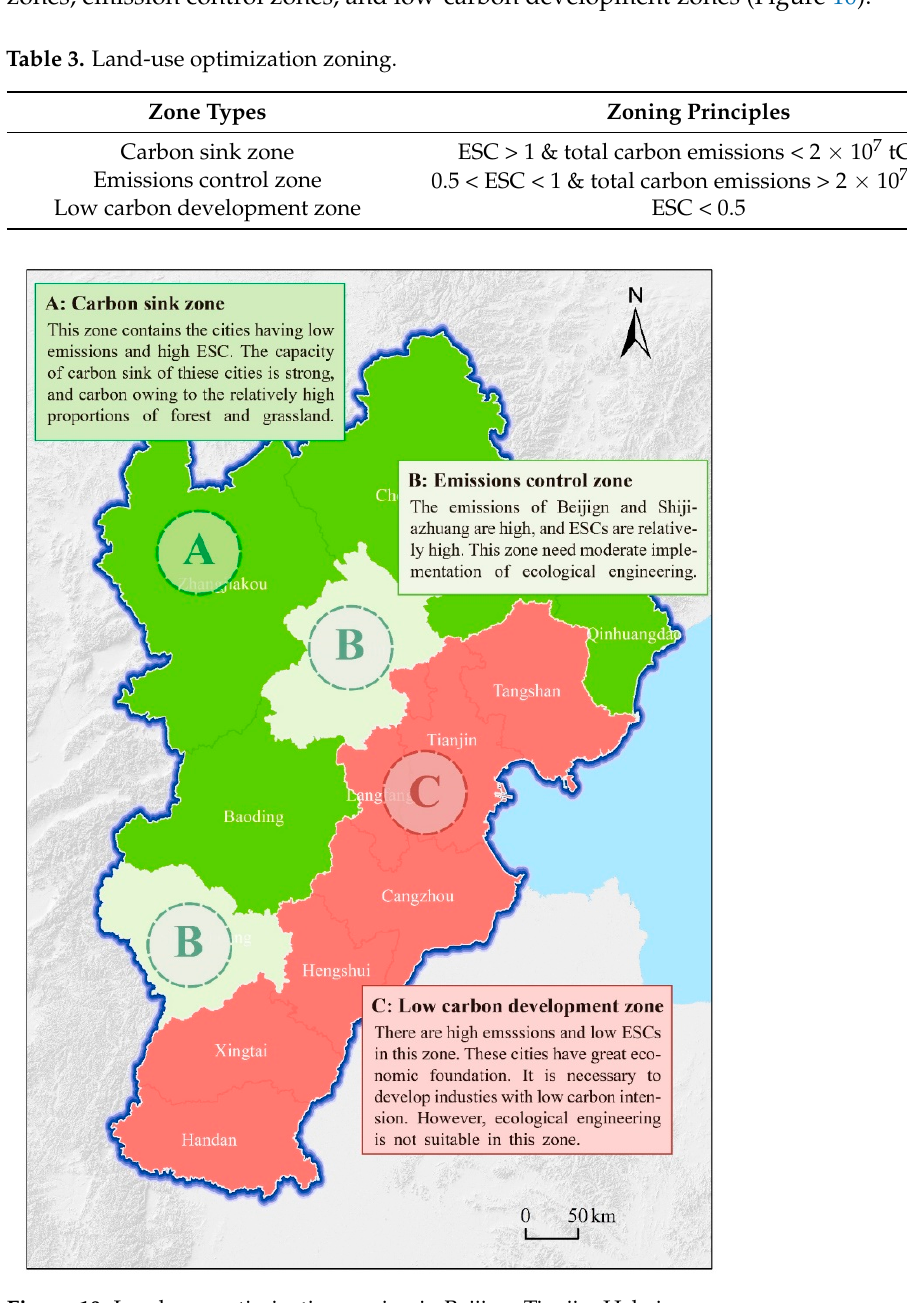
Figure 10. Land-use optimization zoning in Beijing–Tianjin–Hebei.